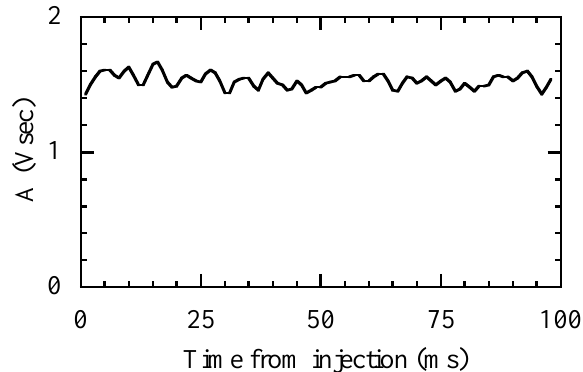
FIG. 4. Bunch area as a function of time from injection.